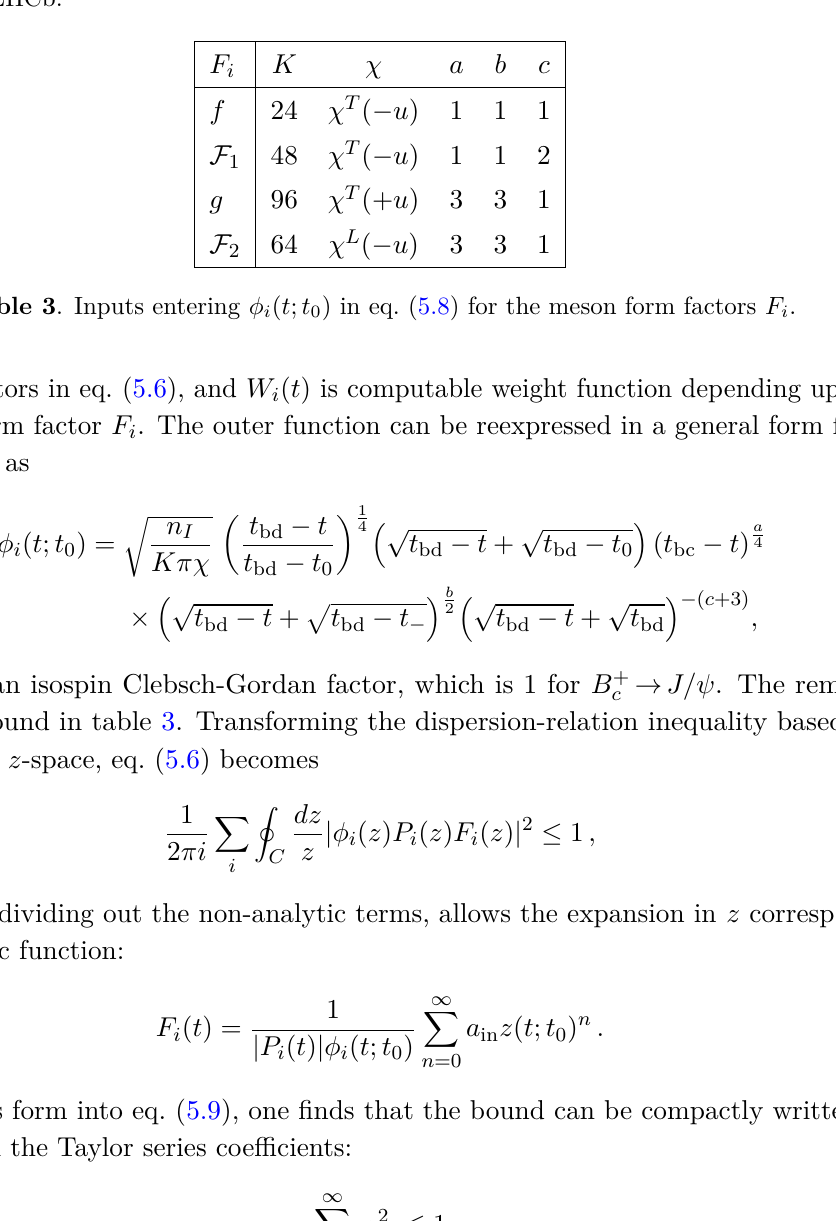
Table 2 . Lowest B + states needed for Blaschke factors with t < t bc (whose relevant two-body c threshold is indicated by “Lowest Pair”) for the J P channels of interest. Bold values indicate masses measured by LHCb.